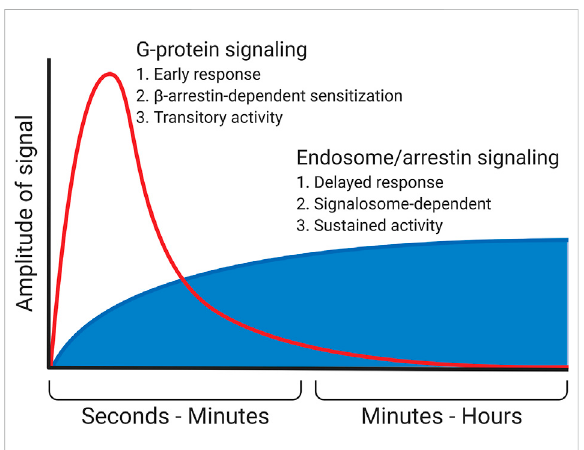
FIGURE 2 Signaling in endosomes. In particular, the β -arrestin – dependent